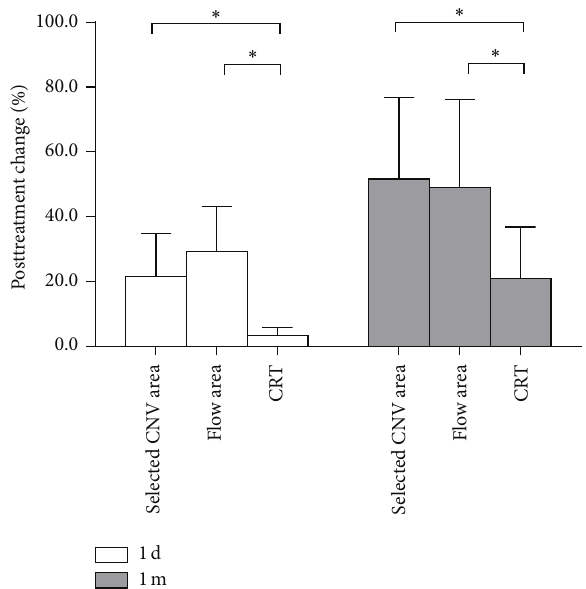
Figure 3: Comparison of 1-day and 1-month posttreatment changes on selected CNV area, flow area, and CRT. ∗ 𝑃 value <